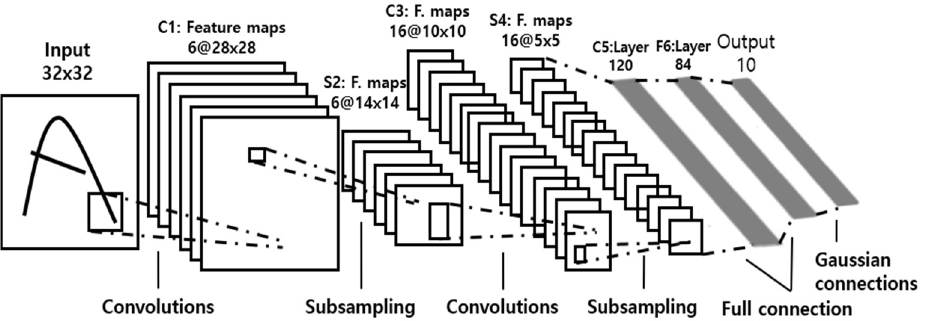
Figure 26. Architecture of LeNet-5 [28]. Table 6. Dataset is of Training data, Validation data, and Test Data.